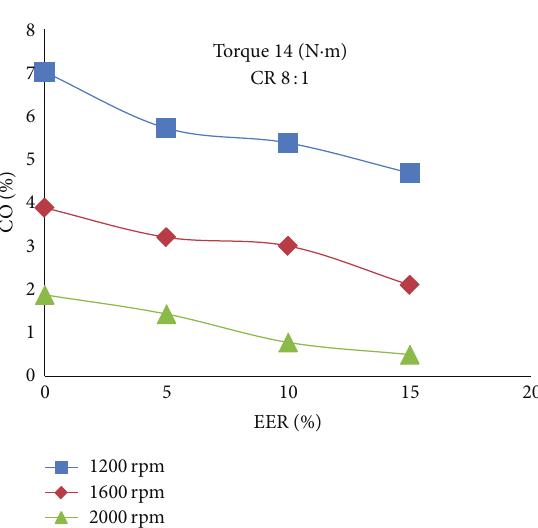
Figure 8: Effect of speed on UHC concentration.